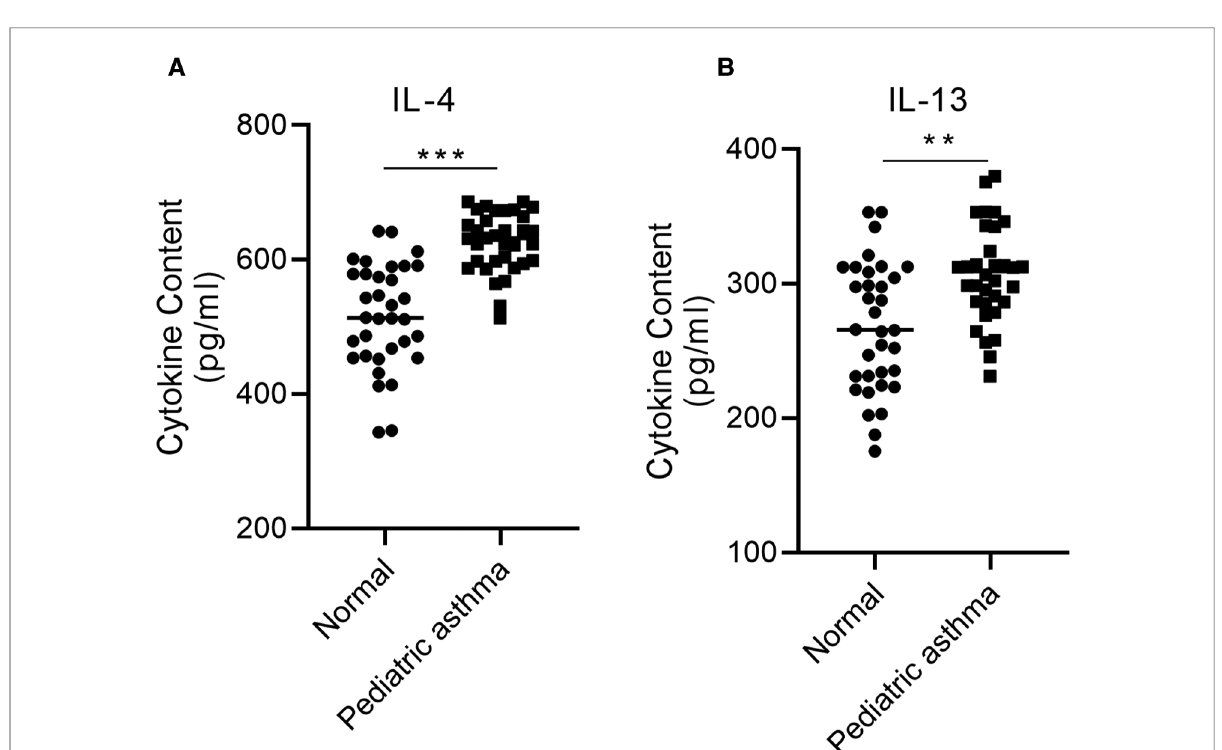
FIGURE 3 IL-4 and IL-13 are highly expressed in the serum of children with asthma. The concentration of ( A ) IL-4 and ( B ) IL-13 in the blood of asthmatic children relative to healthy controls was assessed via ELISA. ** p <0.01, *** p